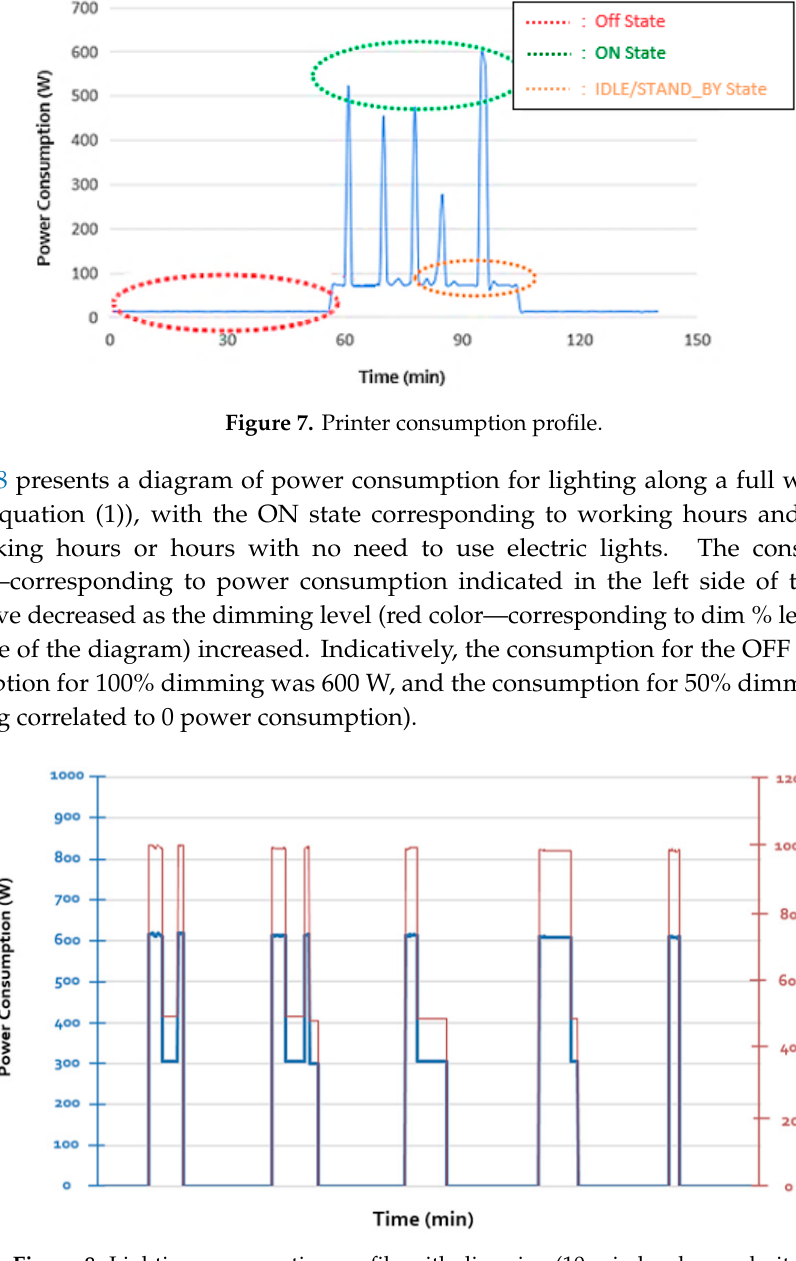
Figure 9. HVAC consumption—indicative macroscopic analysis.